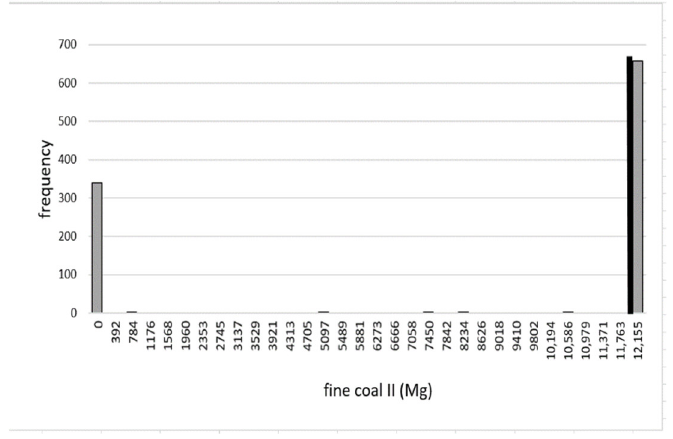
Figure A23. Histogram showing frequencies of achieving given quantity of sales of fine coal II (“Dust kettles”) for mine “G” with σ yprog .